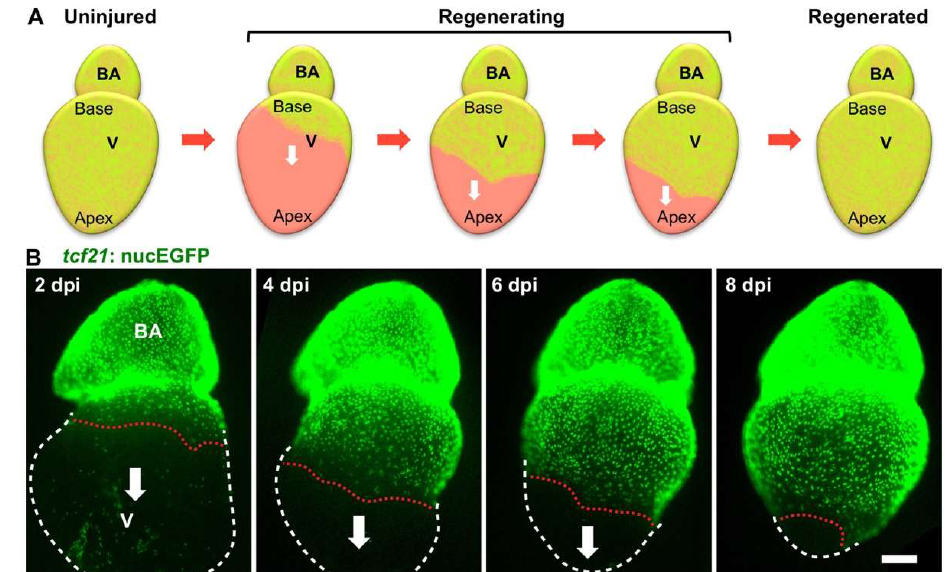
Figure 2. Epicardial regeneration. ( A ) Schematic for epicardial ablation and regeneration. The epicardium is shown in green color. The white arrows indicate the directions of epicardial cell migration; ( B ) explanted adult zebrafish hearts were imaged daily post epicardial ablation. The epicardial cell sheet regenerates along the ventricular surface in a base-to-apex direction (arrows). The nuclei of epicardial cells are labeled with nuclear GFP ( tcf21: nucEGFP). White dashed lines outline the ventricles, and red dashed lines indicate the leading edge of the migrating epicardial cell sheet. Scale bar: 200 μm. BA, bulbous arteriosus; v, ventricle; dpi, days post injury.